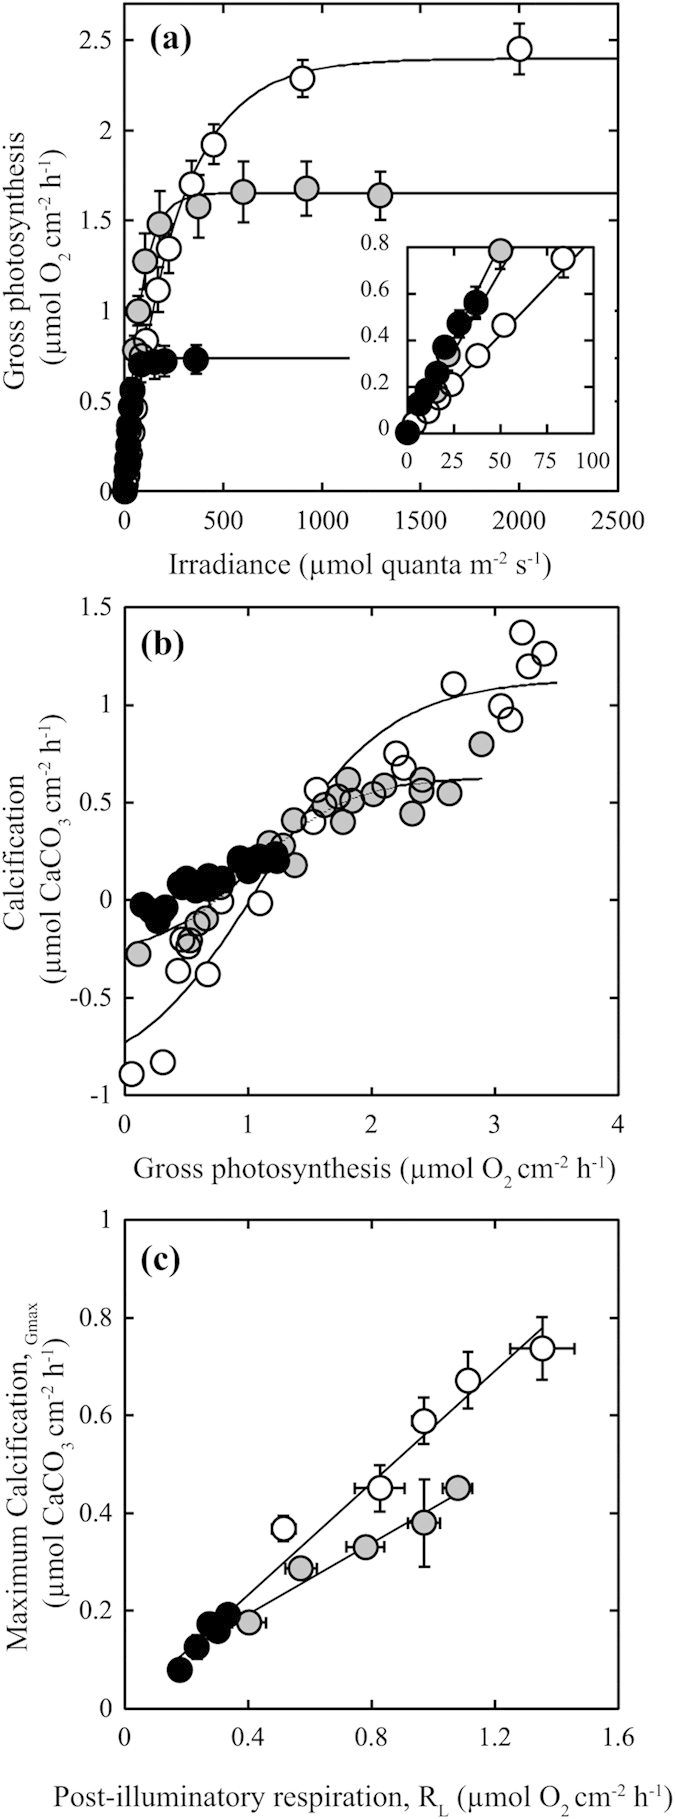
Description of the photosynthetic response to irradiance and the species-specific coupling among metabolic rates for each coralline growth form.(a) Photosynthetic responses to irradiance (P vs. E curve). The variation in photosynthetic efficiency (α, the slope of the linear increase at subsaturating light) is shown in the inserted graph. (b) Non-linear coupling between thallus calcification and gross photosynthesis. The trend lines represent sigmoidal fits (P < 0.05) with R2 = 0.93, 0.91 and 0.86 for rhodoliths, articulated alga and CCA, respectively. (c) Linear coupling between thallus calcification and post-illumination respiration. The trend lines represent linear regression fits (P < 0.05) for (i) pooled CCA and rhodolith data (R2 = 0.97) and (ii) data for the articulated alga Amphiroa tribulus (R2 = 0.97). Symbols represent mean values ± SEM (n = 4–8 determinations per metabolic rate): white circles indicate rhodoliths; grey circles indicate articulated algae; black circles indicate CCA.